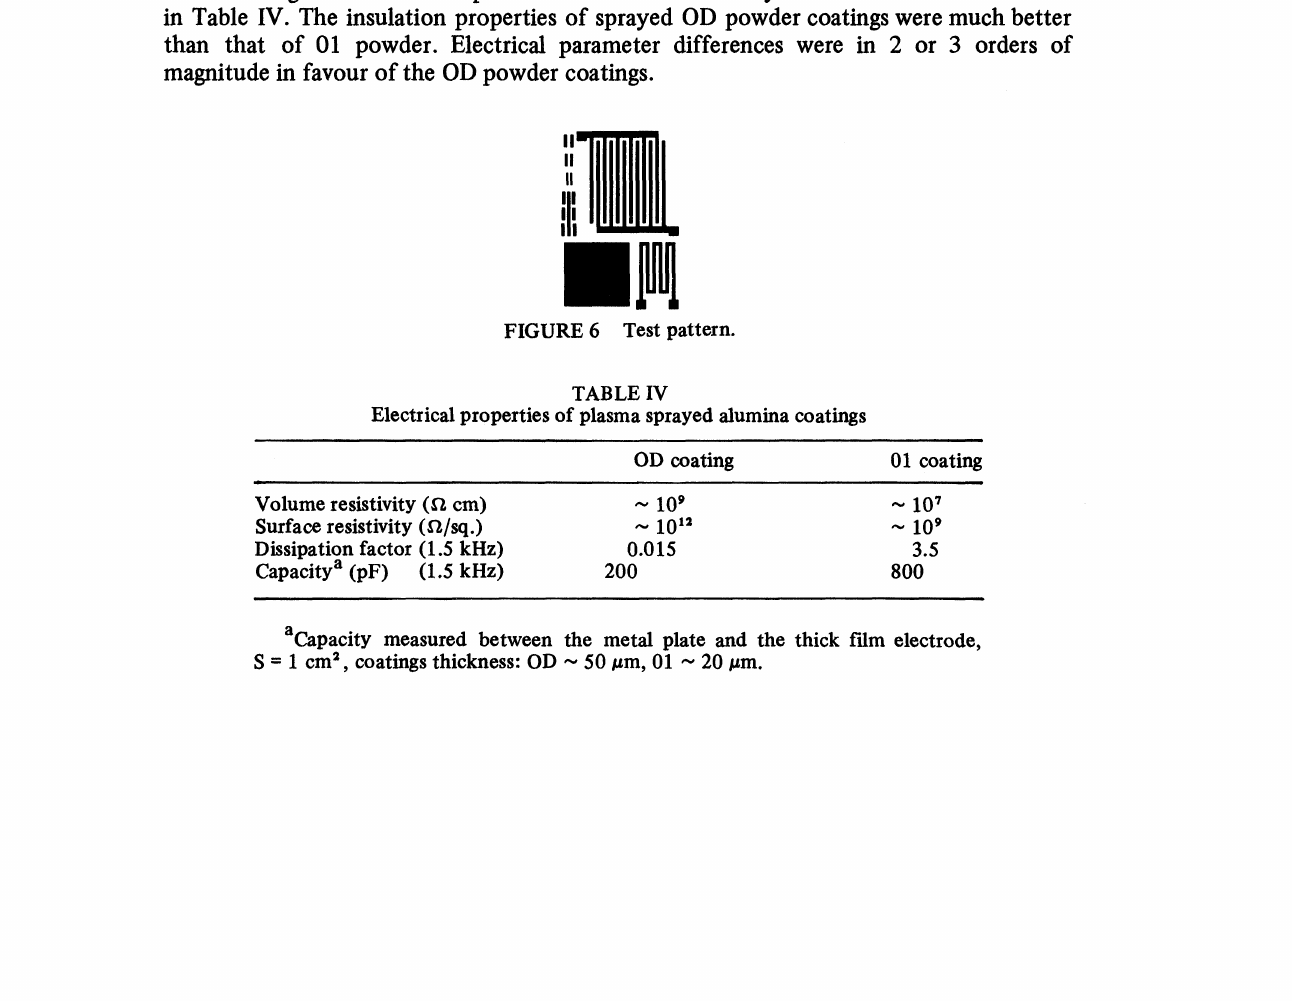
FIGURE 5 Sprayed coating cross-section, powder type 01.